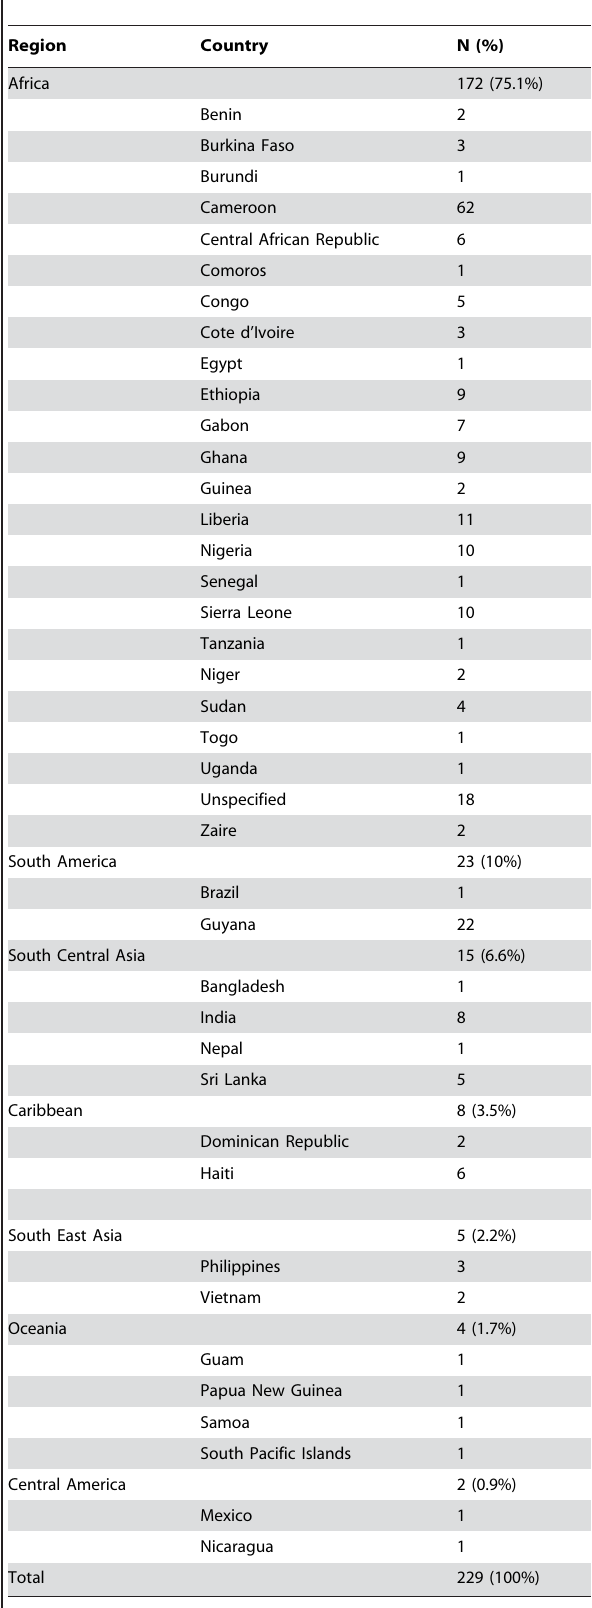
Table 1. Region and countries of exposure to filarial parasite